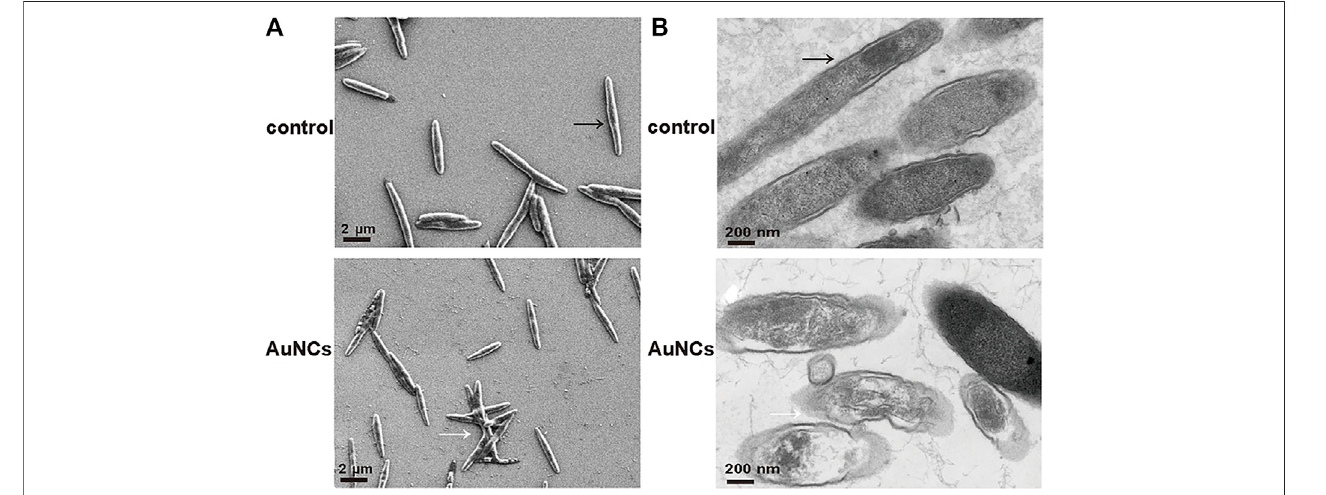
FIGURE 4 | Morphological changes of F. nucleatum exposed to AuNCs (0.2 mM) for 6 h (A) SEM images and (B) TEM